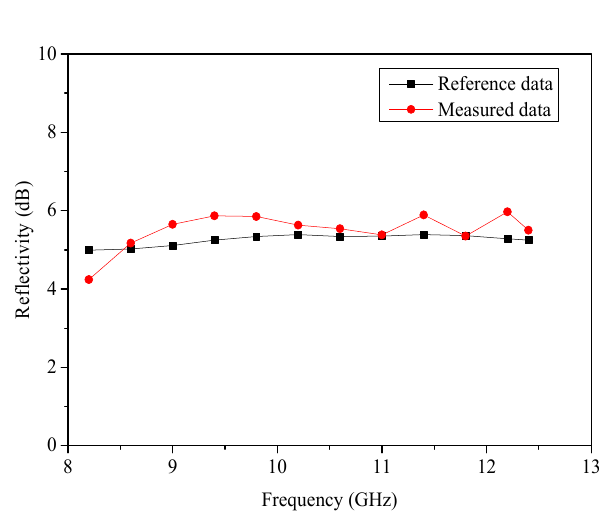
Figure 4. Testing process.